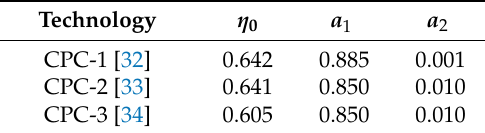
Table 2. CPC efficiency equation